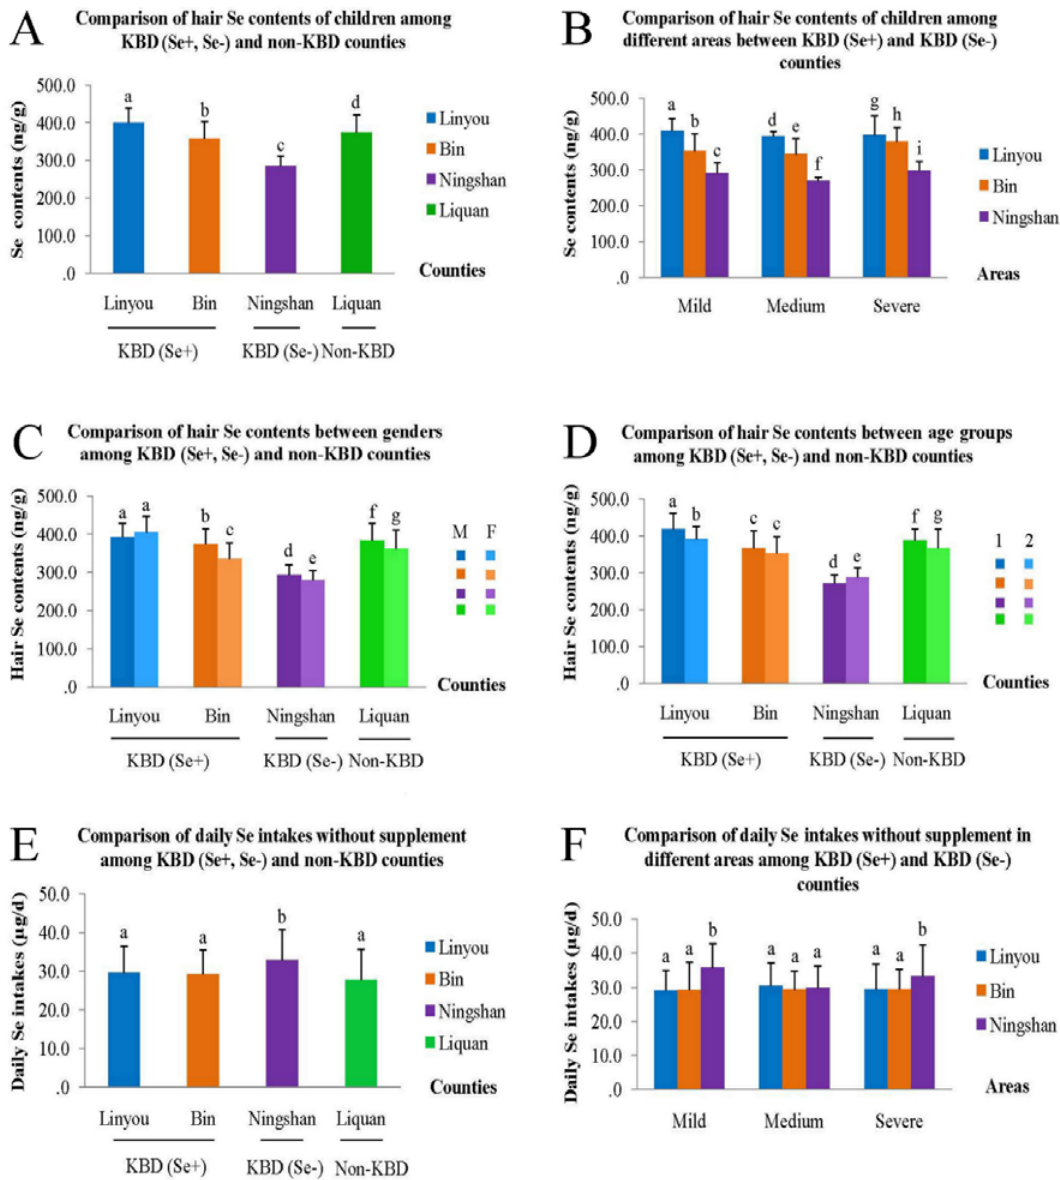
Figure 3. Comparisons of hair Se content and daily Se intake of children in this study. In Figure C, M means male, F means female. In Figure D, 1 means 4.0–6.9 year age group,